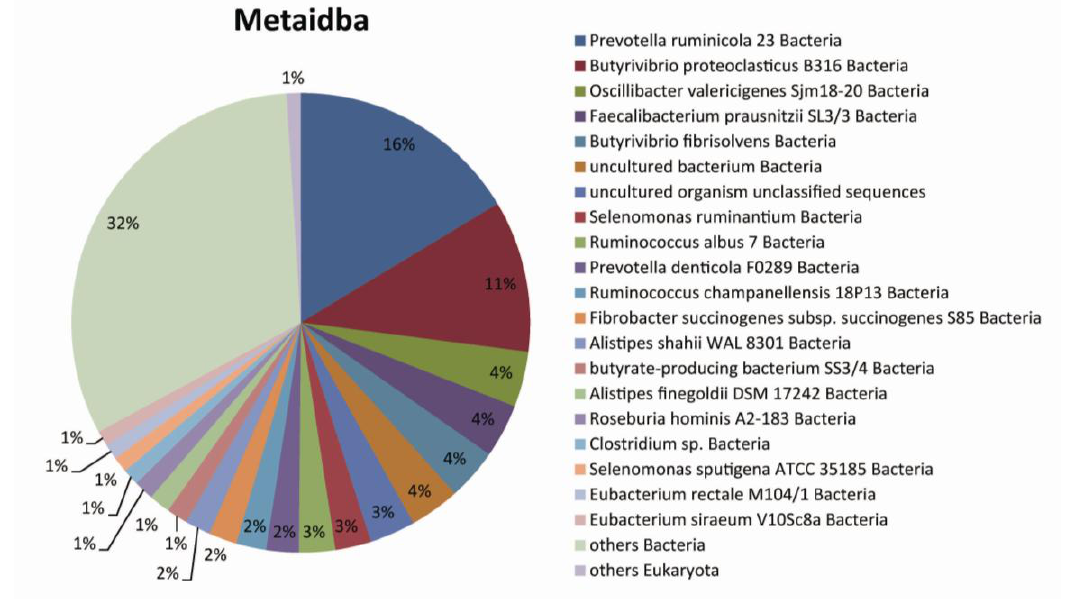
Figure 1. Analysis of the goat rumen microbial community structure at the species